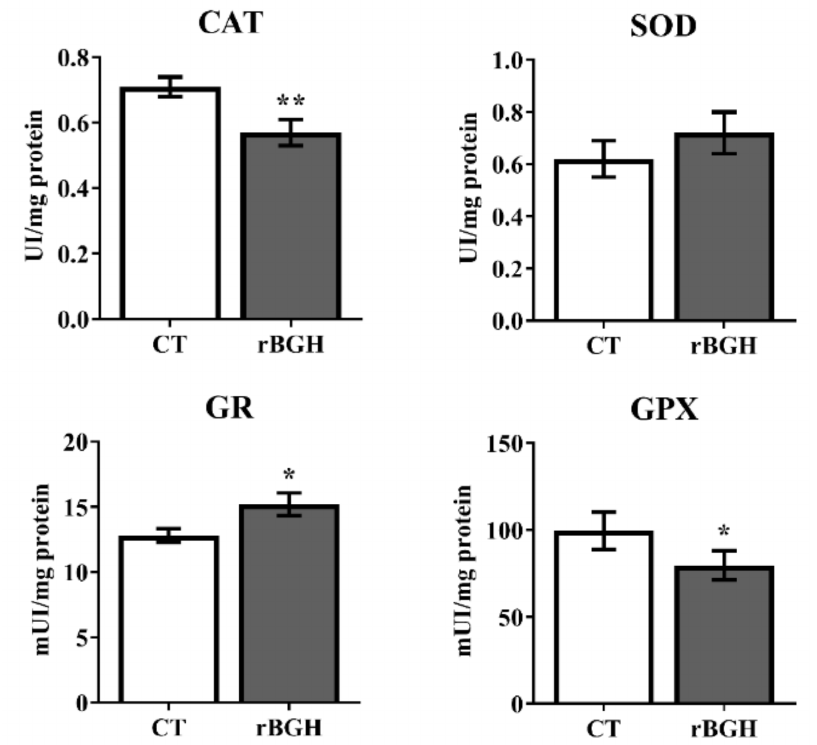
Figure 1. Enzyme activities of redox metabolism in liver after 9 weeks of rBGH injection on gilthead sea bream juveniles. Data are shown as means ± SEM ( n = 12). Significant differences between control and rBGH groups for each enzyme were determined by Student’s t -test and are marked with (*) p < 0.05 or (**) p < 0.01. Abbreviations: catalase (CAT), superoxide dismutase (SOD), glutathione reductase (GR) and glutathione peroxidase